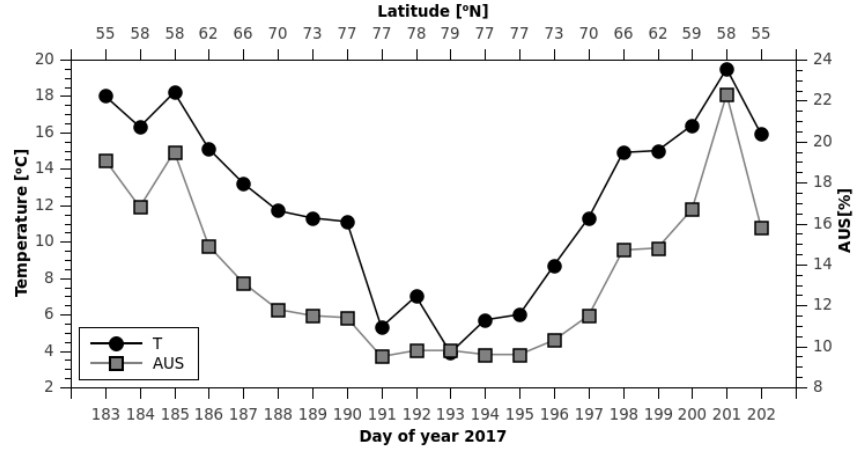
Figure 3. The deck temperature and the area of uncovered skin estimated from Equation (3) on the assumption of zero wind chill factor.